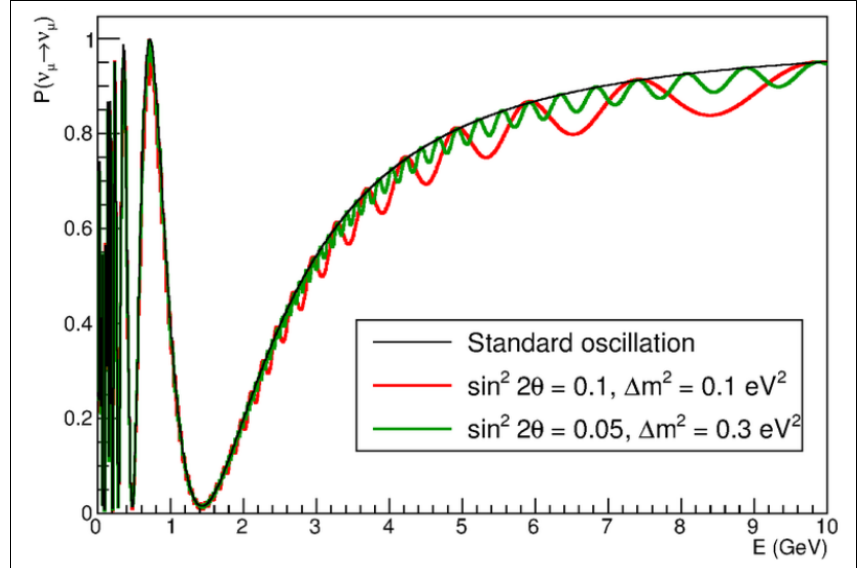
Figure 3. Muon neutrino survival probability at a distance of 735km as a function of the neutrino energy, for different values of the sterile neutrino mass splitting and oscillation angle